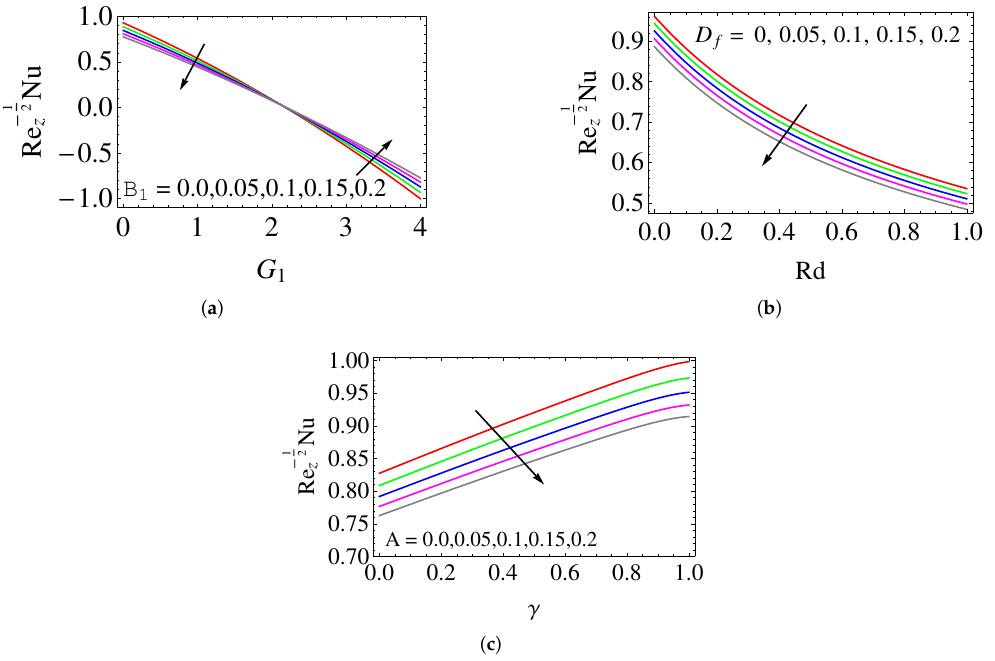
Figure 11. Influences of ( a ) thermal ( B 1 ) slip, ( b ) Dufour number ( D f ) and ( c ) velocity slip ( A ) parameters on Nusselt number.